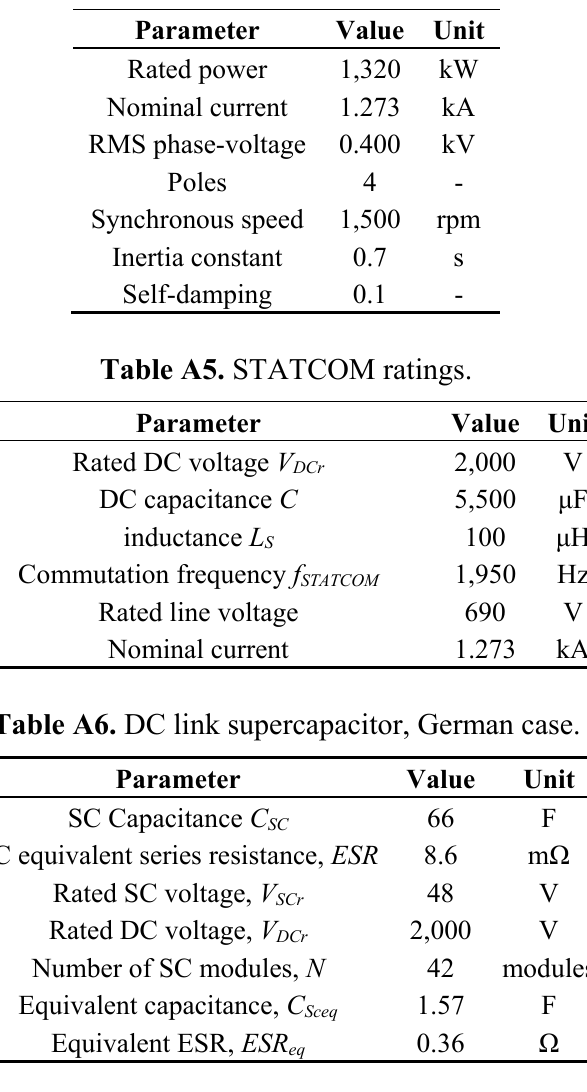
Table A4. Induction generator parameters.